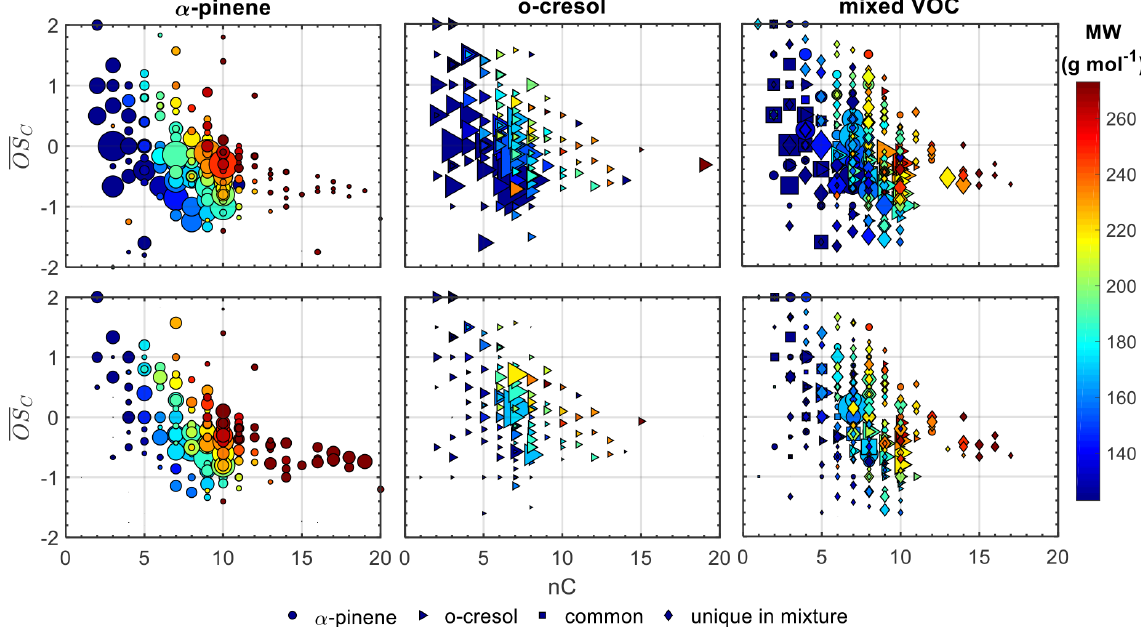
Figure 1. Gas (top panels) and particle (bottom panels) average carbon oxidation states (OSc) against carbon number (nC) for all the products identified in characteristic experiments for each system (experiment nos. 2, 6, and 10; Table 1). In all the experiments the products from each precursor are represented by different symbols, while in the mixed VOC experiment, the products that were common and unique to the mix are also shown. The symbols are sized based on the square root of their signal intensity and are coloured based on their MW.